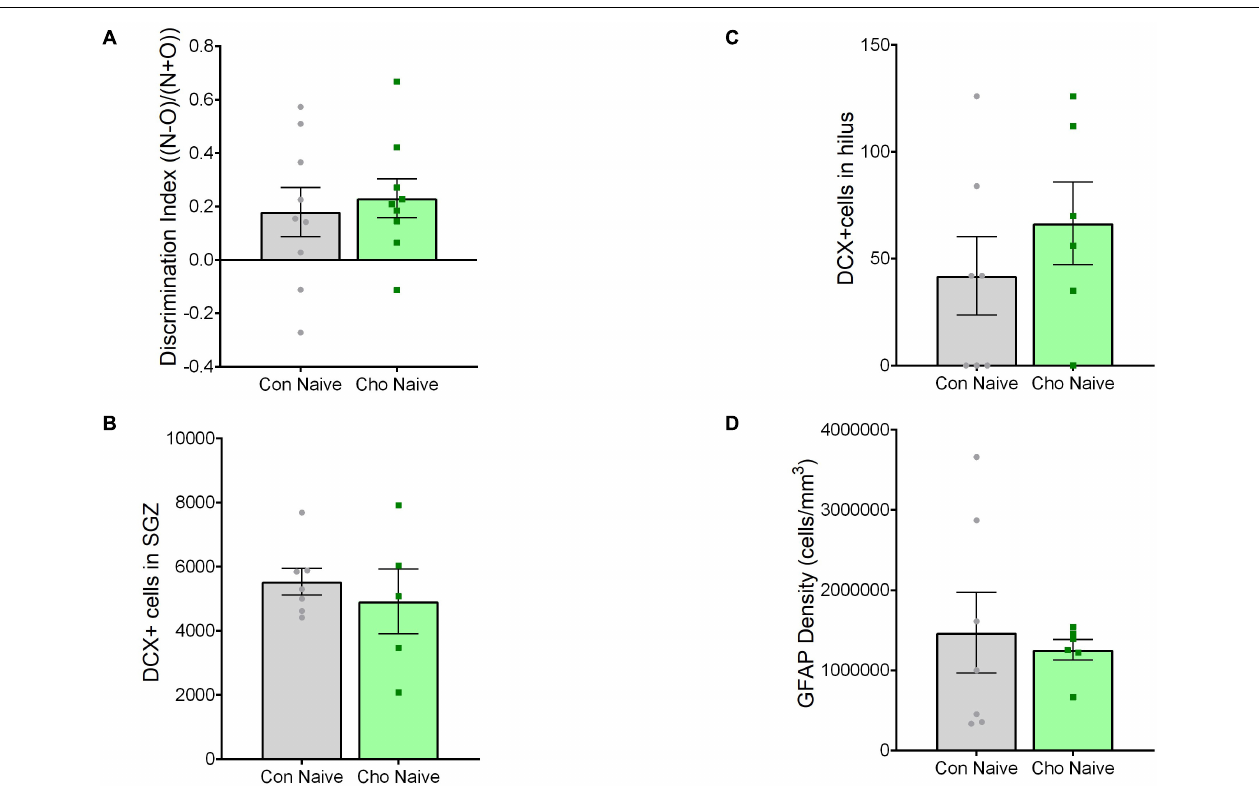
FIGURE 2 | Choline diet alone did not alter hippocampal memory, DCX+ cells, or GFAP antigen density 1 day after surgery. (A) Histogram showing discrimination index [(Novel object time − Old object time)/(Novel object time + Old object time)] 1 day after surgery. N = 9 per group. (B) Histogram showing the number of DCX+ cells in the subgranular zone (SGZ) of the dentate gyrus. N = 5–7 per group. (C) Histogram showing the number of DCX+ cells in the hilus of the dentate gyrus. N = 6–7 per group. (D) Histogram showing the antigen density of GFAP in the dentate gyrus of the hippocampus. N = 7 per group. Each bar represents the mean ± SEM. Con Naïve, control diet + naïve; Cho Naïve, choline diet +